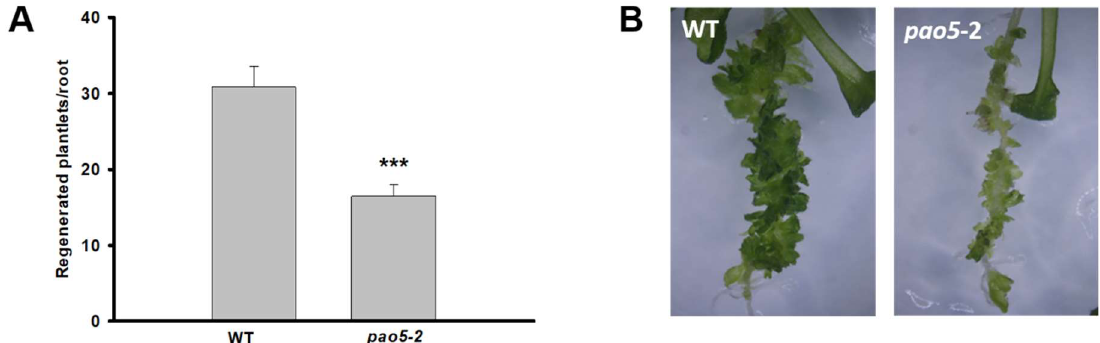
Figure 1. pao5-2 T-DNA insertion mutant plants show a decrease in the efficiency of the conversion of lateral root primordia into shoots. ( A ) Shoot regeneration rate of seedling roots of wild type (WT) and pao5-2 mutants after 10 days of cytokinin induction. Data are means ± SE of three biological replicates with twenty technical replicates each. For significance analysis Student’s T-test was used. (*** p ≤ 0.001). ( B ) Representative images of shoot-regenerating seedling roots.